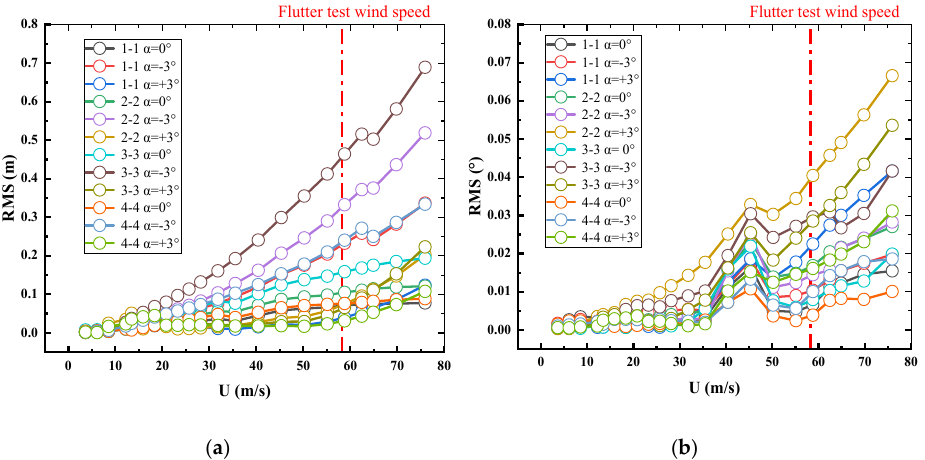
Figure 19. The root mean square (RMS) value of the displacement of each measure point of the service state in uniform wind. ( a ) Vertical; ( b ) torsional.